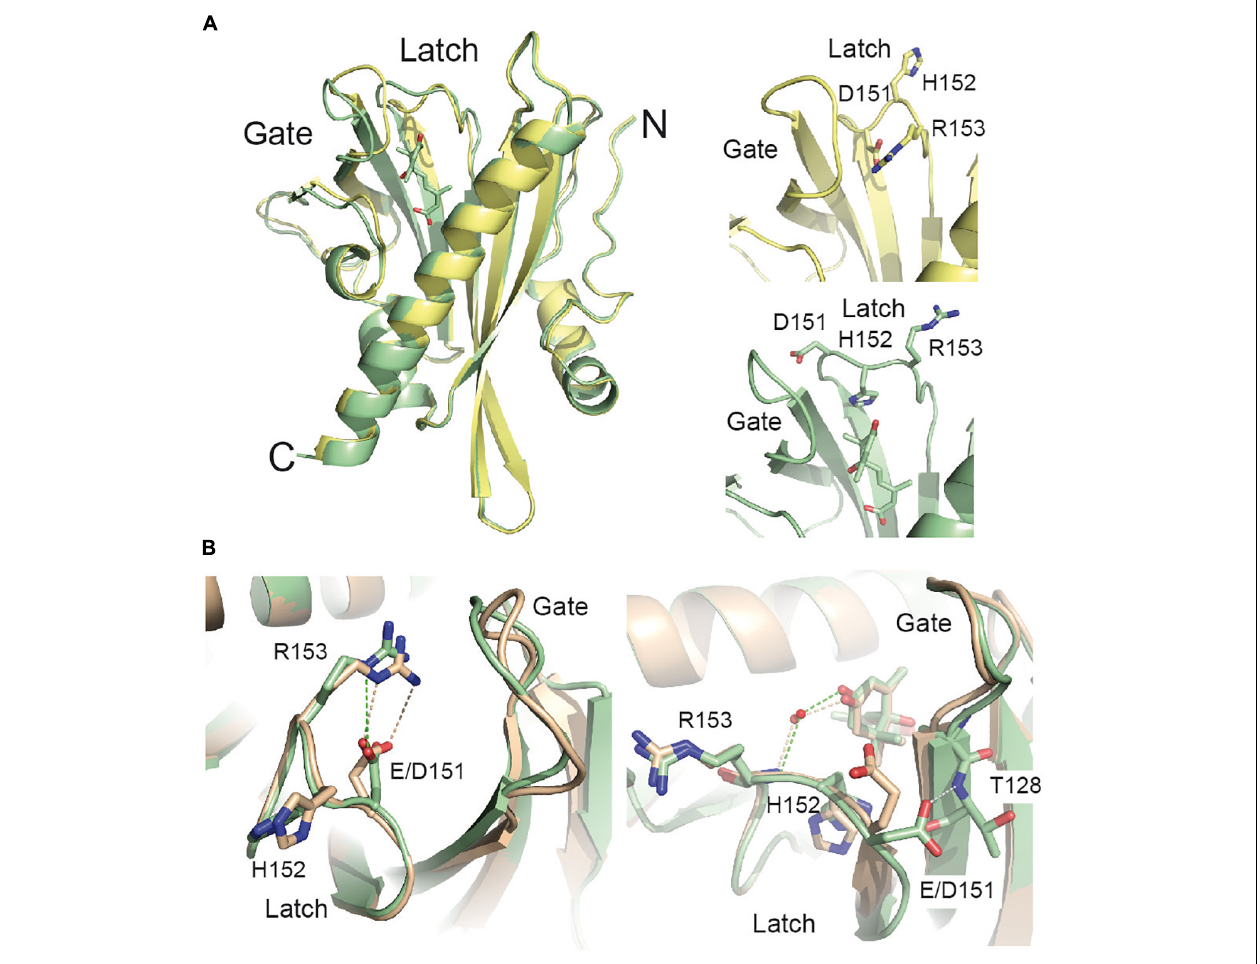
FIGURE 2 | The structure of the SlPYL1 E151D. ( A ; Right) Superposition of the structures of the apo and ABA bound SlPYL1 E151D (yellow and green, respectively) together with a detail of the residues conforming the Glu/Asp-His-Arg motif (left). The view faces the dimerization interface. The latch and gate loops are highlighted. (B) Superposition of a section of the structures of the apo and ABA bound SlPYL1 E151D (green; upper and lower panel, respectively) and SlPY1 in complex with ABA [wheat; Protein Data Bank (PDB) codes 5MOA and 5MOB, respectively]. Hydrogen bonds are represented as dashed